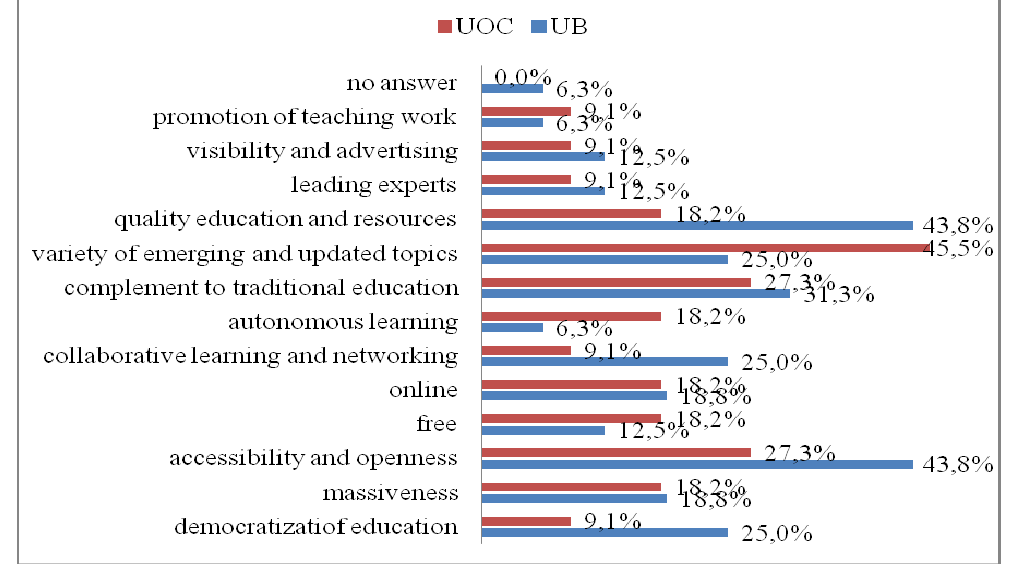
Figure 5. Comparison of the perceptions of teachers from both universities about the pedagogical